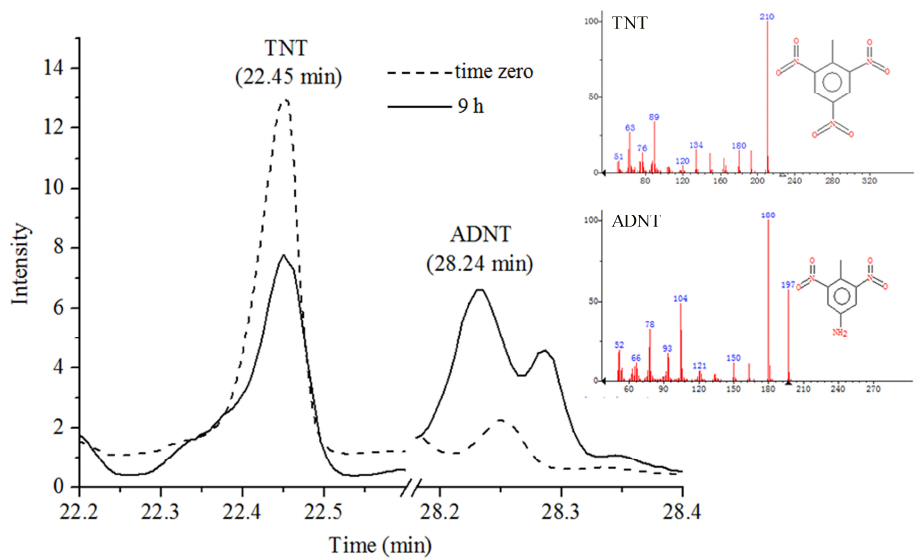
Figure 4. GC-MS analysis of TNT metabolite following degradation by wild-type strain S19-1. The figure shows peaks corresponding to TNT and ADNT at time zero (short dashes), i.e., before incubation and after 9 h incubation with Buttiauxella sp. S19-1 (solid lines). Note the decline of TNT and formation of ADNT over